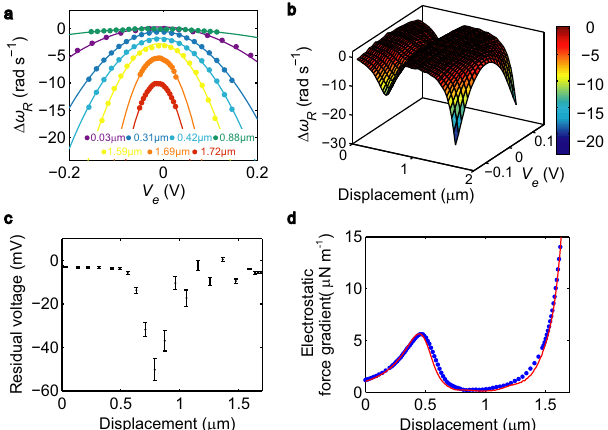
Fig. 3 Calibration using the electrostatic force. a Measured Δ ω R as a function of V e . The dots are measured data and the solid lines are parabolic fi ts. For each parabola, the displacement of the grating attached to the comb actuactor is labeled with the corresponding color. b Measured Δ ω R as a function of displacement d and V e . c Measured residual voltage V 0 as a function of displacement. Error bars show the spread of data over several independent measurements. d Measured electrostatic force gradient with V e ¼ V 0 þ 100mV (blue) is fi tted with calculations using the fi nite elements method (red). The error bars are comparable to the dot size.